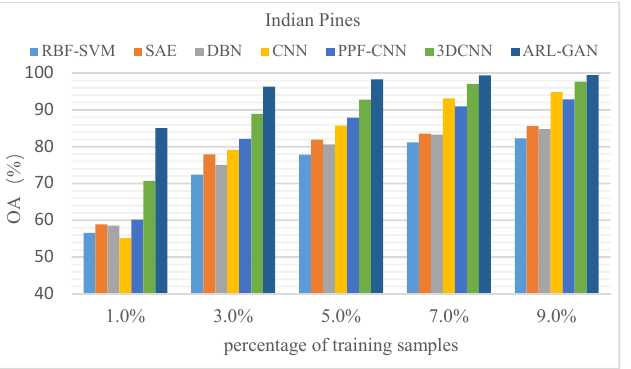
Figure 7. Accuracy of seven classification algorithms for the Indian Pines dataset under different numbers of training samples.